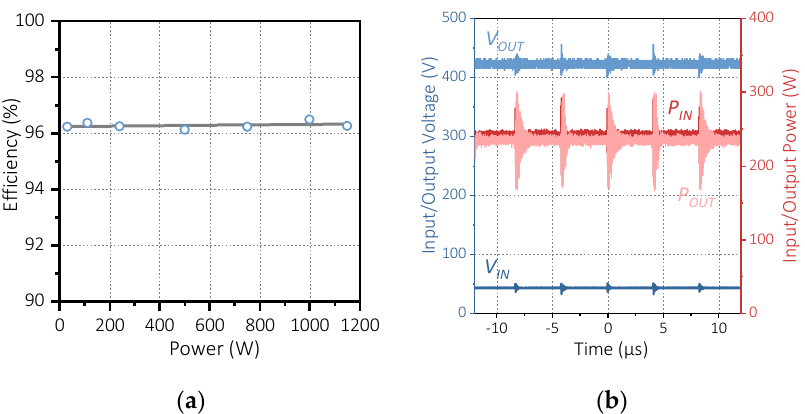
Figure 11. Experimental results of the developed 10X converter. ( a ) Efficiency curve over operating power and ( b ) voltage and power waveforms during operation at 250 W.